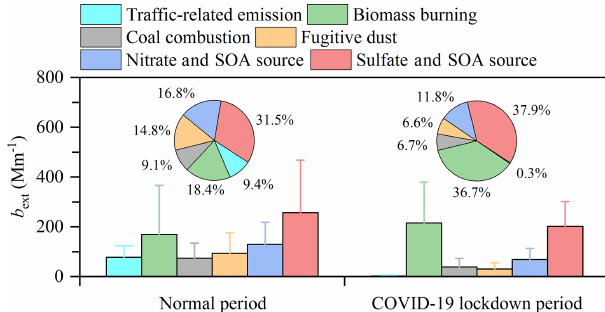
Figure 6. Contributions of six resolved sources to the modelled source light extinction coefficient ( b ext ) during the normal and COVID-19 lockdown periods, including traffic-related emissions, biomass burning, coal combustion, fugitive dust, the nitrate and SOA source, and the sulfate and SOA